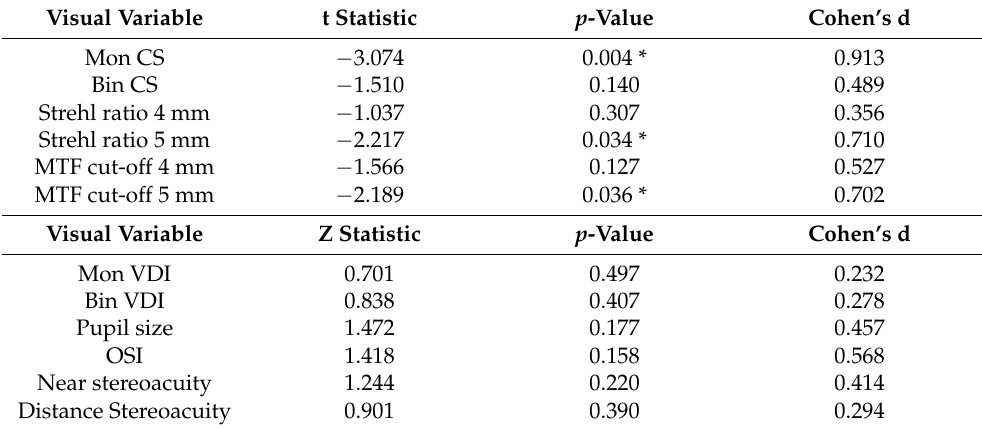
Table 3. Results of the t -test for independent samples and Mann–Whitney U test (degrees of freedom = 35) showing how biological sex influences the deterioration of the different visual functions.